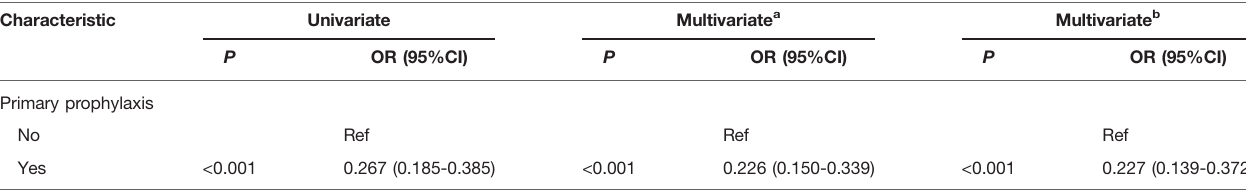
TABLE 3 | Univariate and multivariate analyses of associations between primary prophylaxis and rebleeding. Characteristic